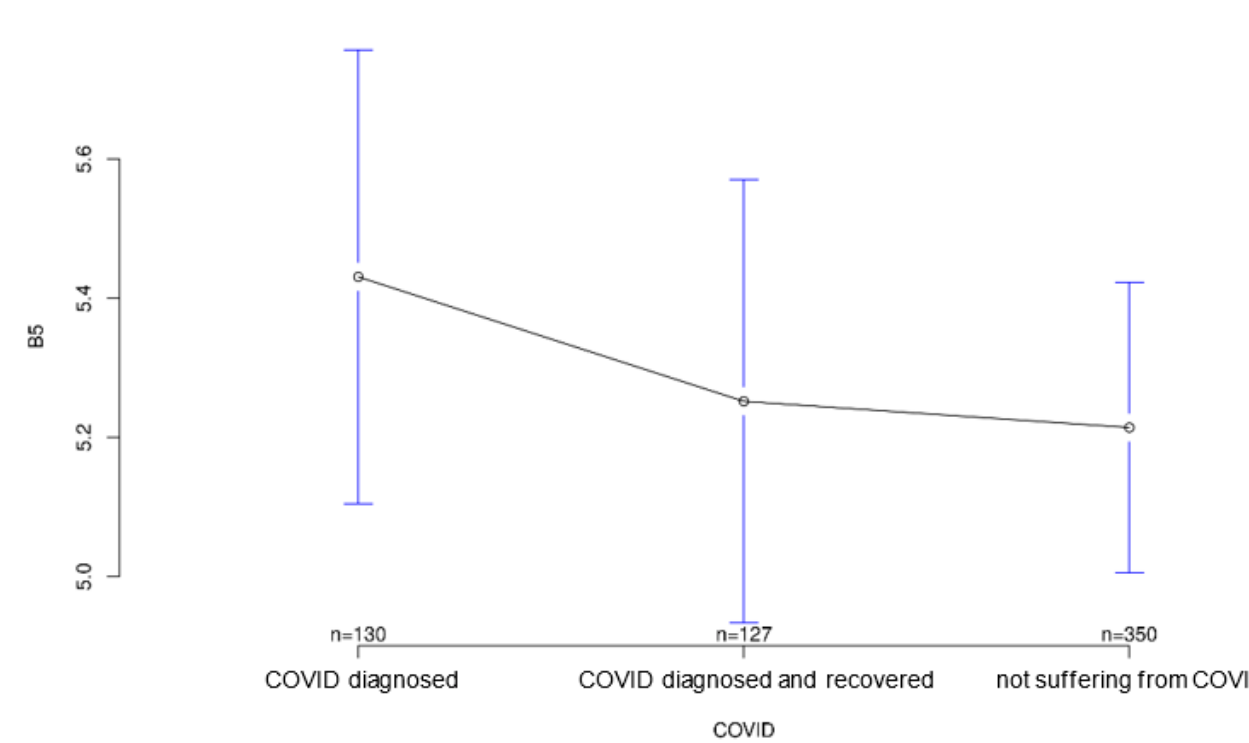
the mean result of participants choice on the Likert scale.